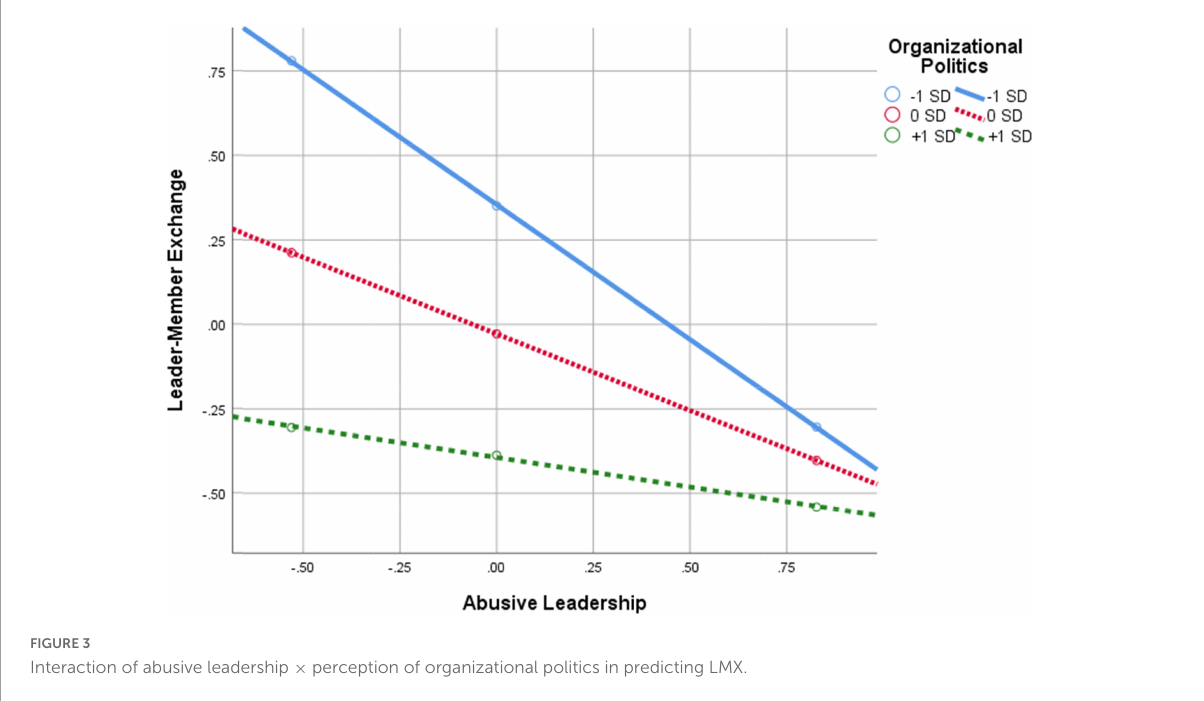
FIGURE3 Interaction of abusive leadership × perception of organizational politics in predicting LMX.